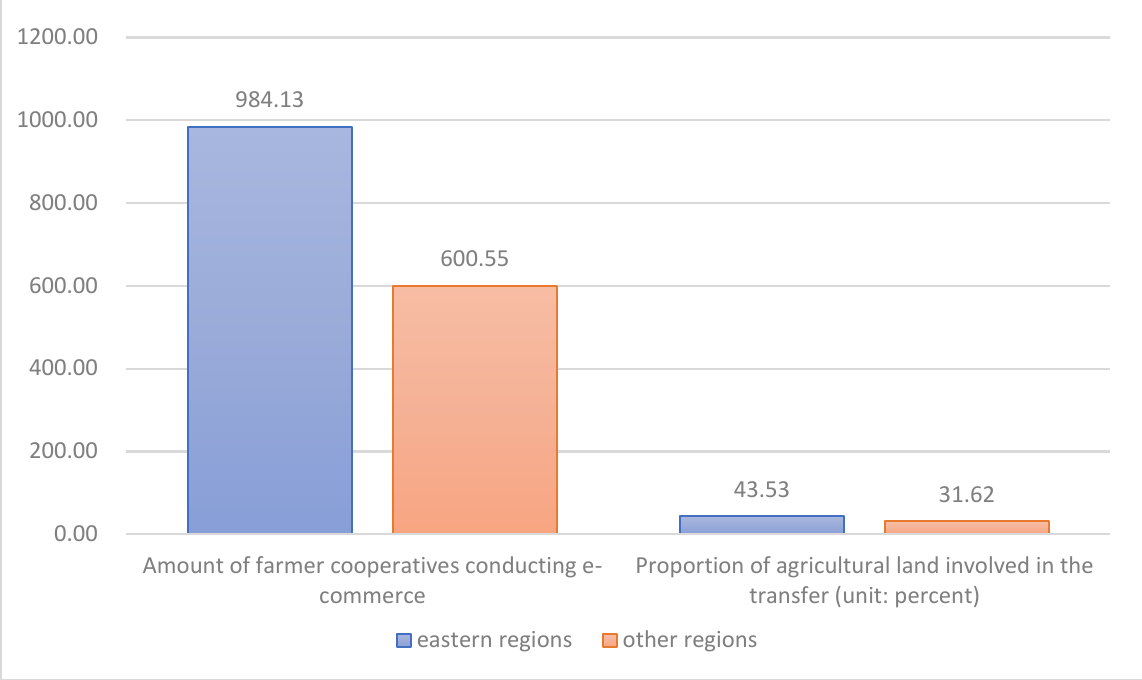
Figure 6. Average market-oriented development level of rural products and factors in 2018 (Data source: Ministry of Agriculture and Rural Affairs of China. China Agricultural Management Statistical Annual Report (2018). Beijing, P. R. China http://zdscxx.moa.gov.cn:8080/nyb/pc/messageList.jsp (accessed on 10 October 2020)).